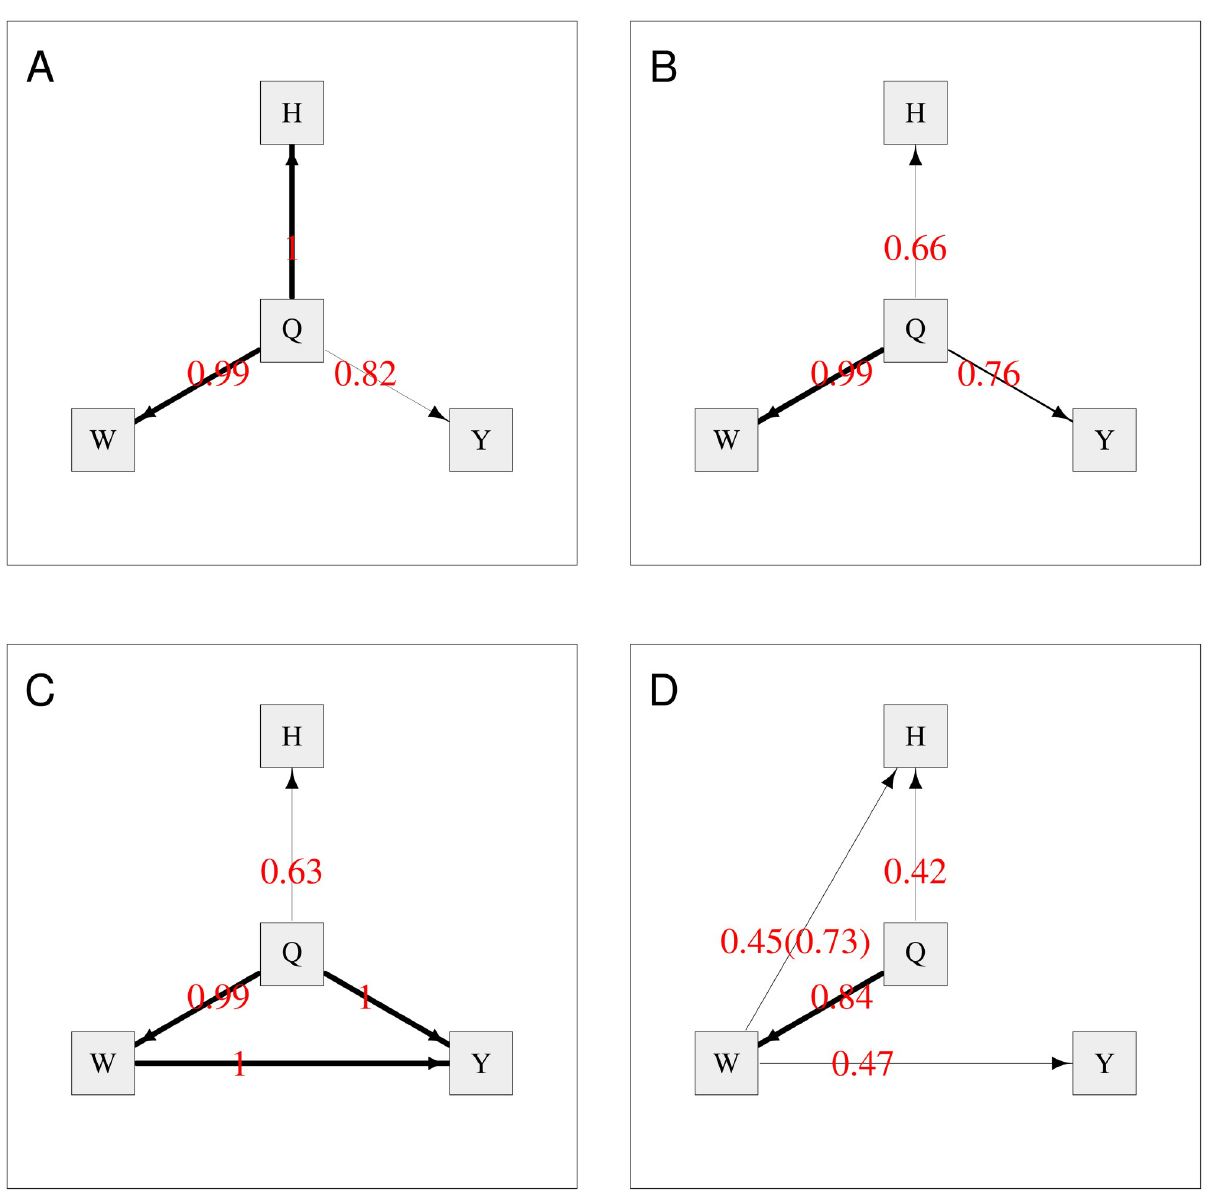
Fig 9. Average Bayesian networks for each of the four scenarios (A–D) used for the simulated binary data. The red numbers indicate the probability of existence of an edge, and the numbers in brackets indicate the probability of the edge operating in direction shown, given that it exists. The thickness of the edges indicates their strength (probability of existence). G is constrained to have no parents and Y is constrained to have no